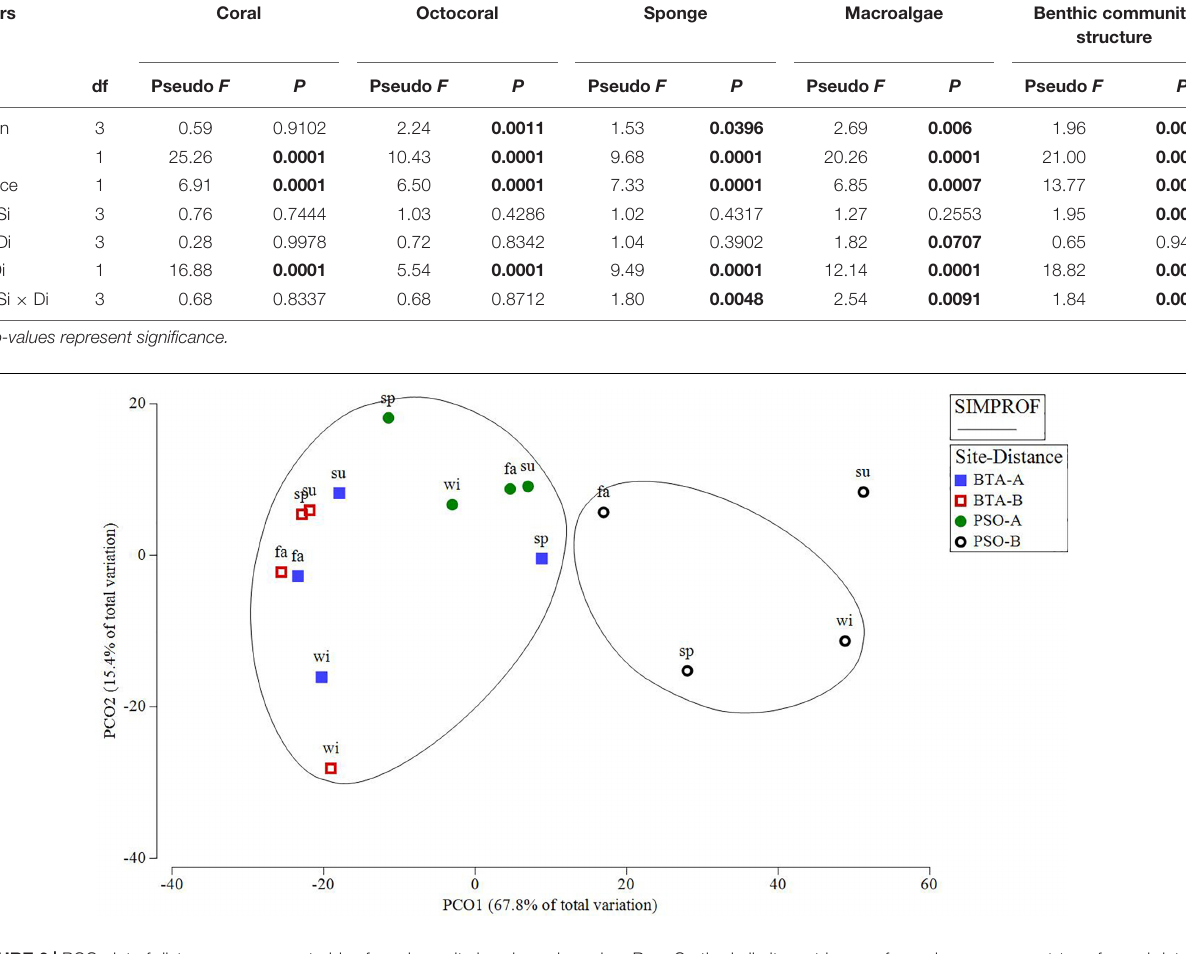
FIGURE 6 | PCO plot of distance among centroids of coral recruit abundance based on Bray-Curtis similarity matrices performed on square root-transformed data by seasons-site-distance clusters. Clusters represent significant SIMPROF groups ( ∼ 75% similarity within groups). This model explained 83.2% of the observed spatio-temporal variation in coral recruit abundance by site and distance zone. Blue and red squares represent Bahía Tamarindo (BTA); green and black represent Punta Soldado (PSO). Seasons are defined as: sp, spring; su, summer; fa, fall; wi,